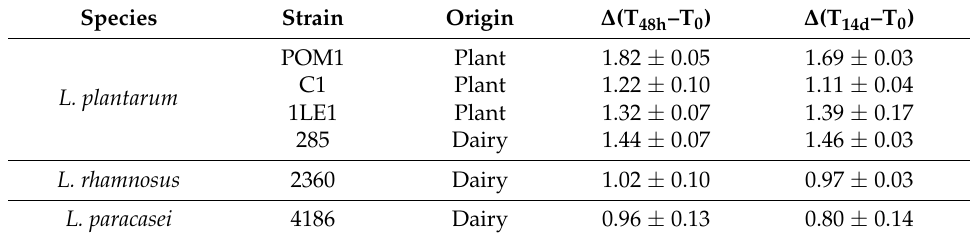
Table 2. Lactic acid bacteria growth. Difference in Log CFU/mL detected between cells number after 48 h of incubation and the initial value, ∆ (T 48h –T 0 ), and between cells number after storage (14 days) and the initial value, ∆ (T 14d –T 0 ). The isolation origin (plant/dairy products) is specified. Only the strains able to grow are